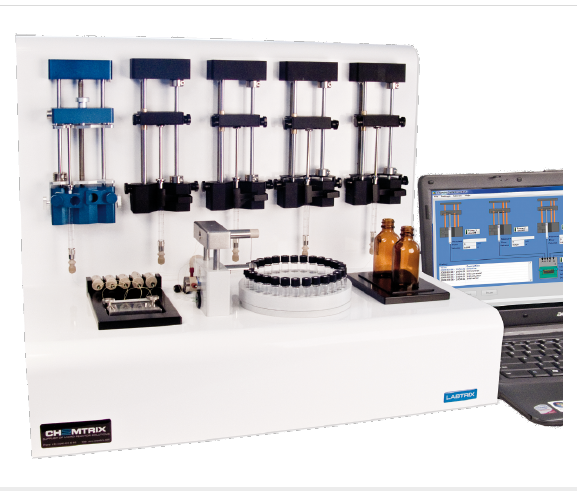
Figure 2: Photograph illustrating Labtrix ® S1, the automated micro- reactor development apparatus from Chemtrix BV (NL), used for the evaluation described